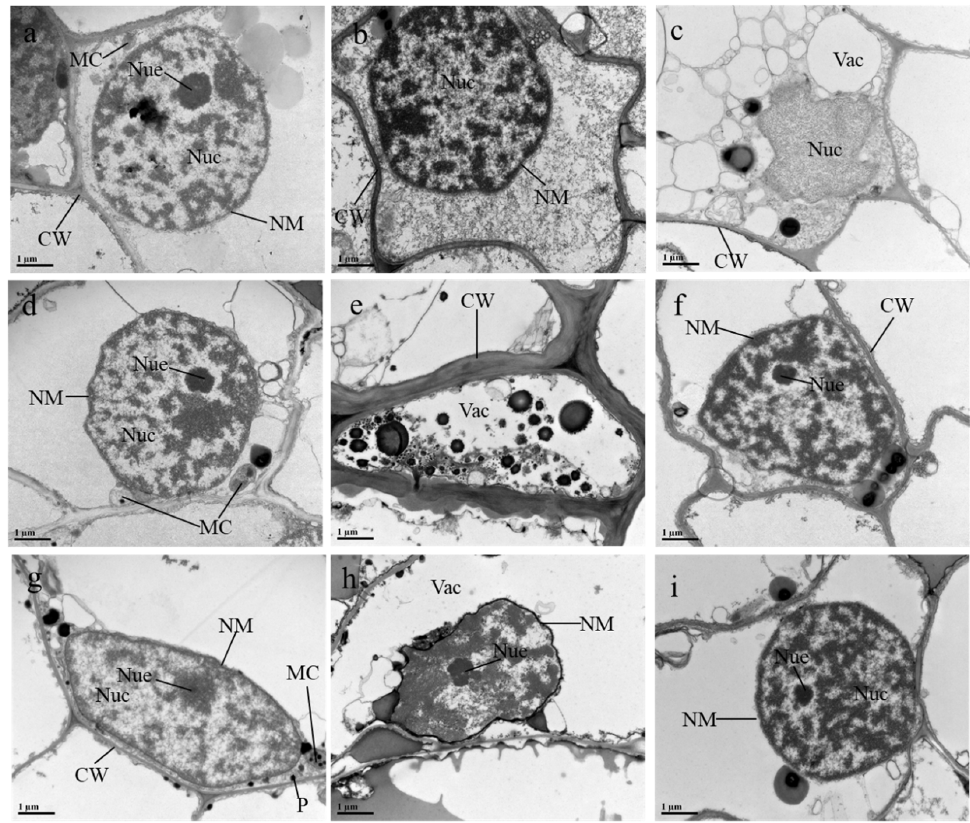
Figure 5. Effects of 5-aminolevulinic acid or salicylic acid (ALA/SA) combined with citric acid (CA) on electron micrographs of root cells of manganese (Mn)-treated sunflower plants. ( a – c ) represent electron micrographs of root cells of sunflowers under CK, Mn and Mn + CA treatment, respectively; ( d – f ) represent electron micrographs of root cells of sunflowers under ALA, Mn + ALA and Mn + CA + ALA treatment, respectively; ( g – i ) represent electron micrographs of root cells of sunflowers under SA, Mn + SA and Mn + CA + SA treatment, respectively. CK, control plants without any treatment; Mn, plants exposed to 0.8 g kg − 1 Mn for 7 days; CA means 20 mmol kg − 1 citric acid treatment. ALA/SA indicates spraying with 20/100 mg L − 1 ALA/SA. Mn + CA, plants treated with CA for 7 days after Mn treatment. Mn + CA + ALA/SA treatment indicates plants treated with ALA/SA for one week after CA treatment. Plates explanation: MC, mitochondria; NM, nuclear membrane; Nuc, nucleus; Nue, nucleolus; CW, cell wall; CM, cell membrane; P, plastoglobuli. ( a ~ i ) — ×20000.